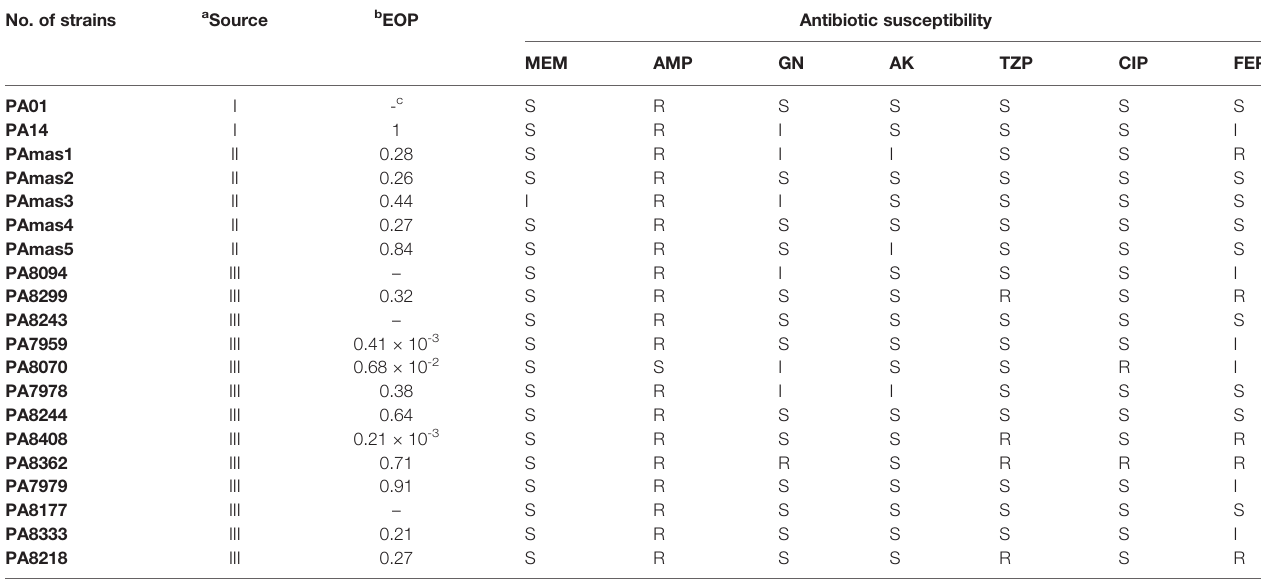
TABLE 1 | Drug resistance of strain and lytic activity of phage PAJD-1. No. of